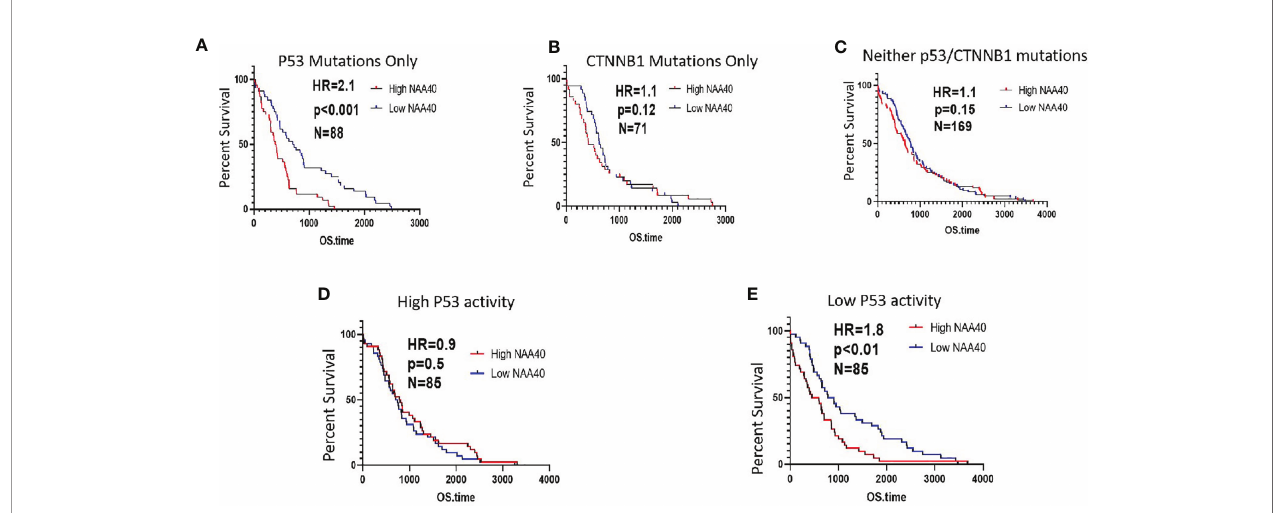
FIGURE 5 | High NAA40 expression predicts worse survival for LIHC patients with inactivated P53 (A – C) Kaplan-Meier survival curves for LIHC patients in the TCGA study carrying P53 mutations, CTNNB1 mutations or no mutations on either of the two genes divided according to median NAA40 expression; (D, E) Kaplan- Meier plots for LIHC samples with no registered P53 mutations that were divided into two groups according to P53 activity using a previously described 10-gene signature. Hazard ratio (HR) and p values were calculated using the log-rank